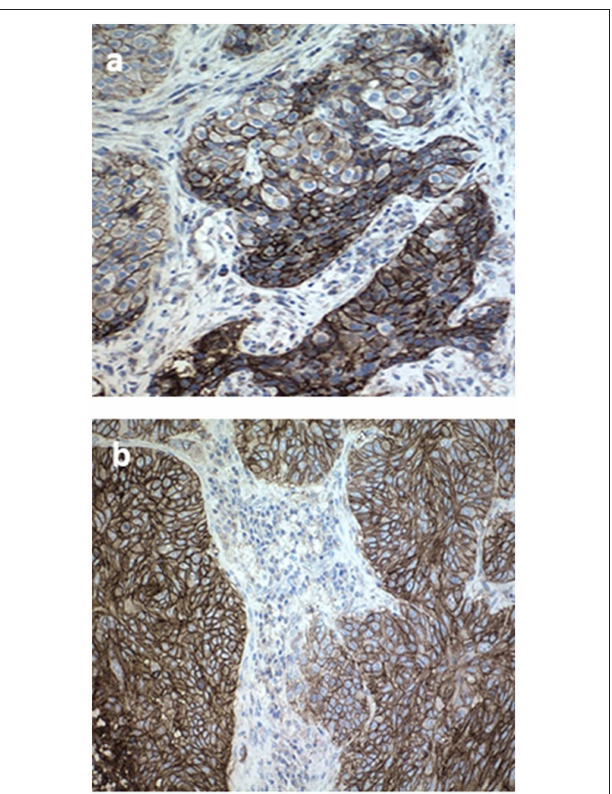
FIGURE 3 | Tissue specimen of primary tumor sample and brain metastases. (a) Immunohistochemistry stained with PD-L1 primary antibody (28-8 pharmaDx; Dako) in a pretreated formalinfixed paraffin-embedded tissue of primary lung tumor before treatment, exhibiting strong membrane staining in 100% of tumor cells (20 × magnification). (b) Cerebellar tissue specimen after complete